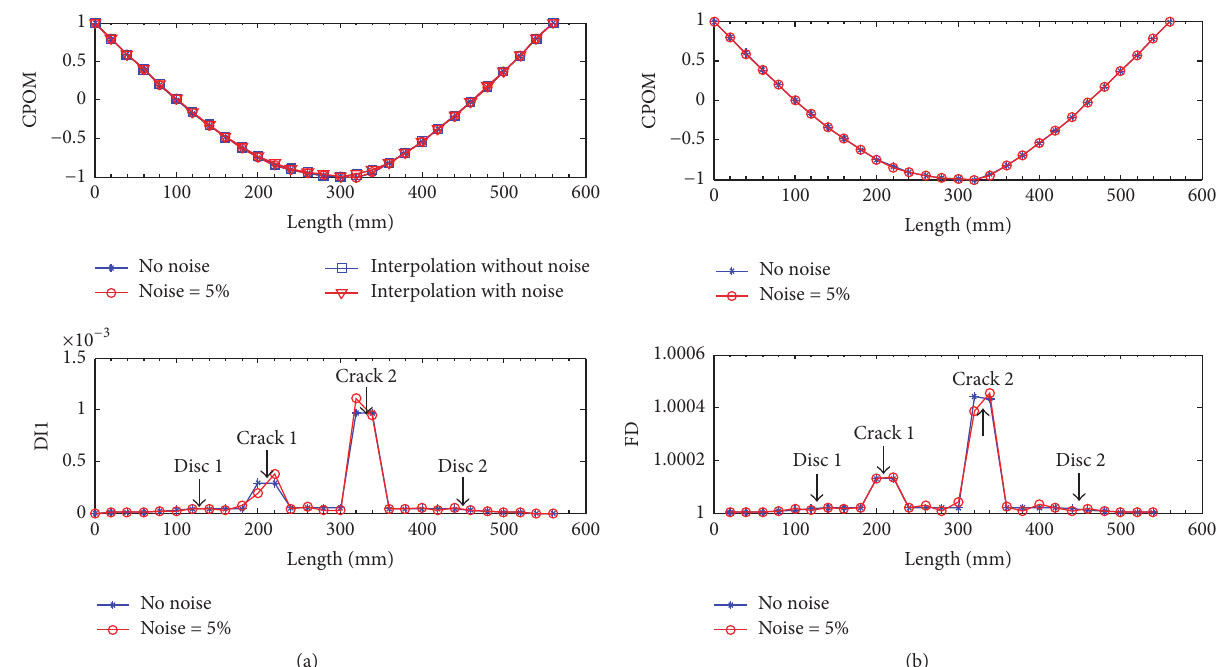
Figure 11: Localization results of double-cracked rotor in case 4. (a) Localization using GSM by linear gapped interpolation. (b) Localization using FD.